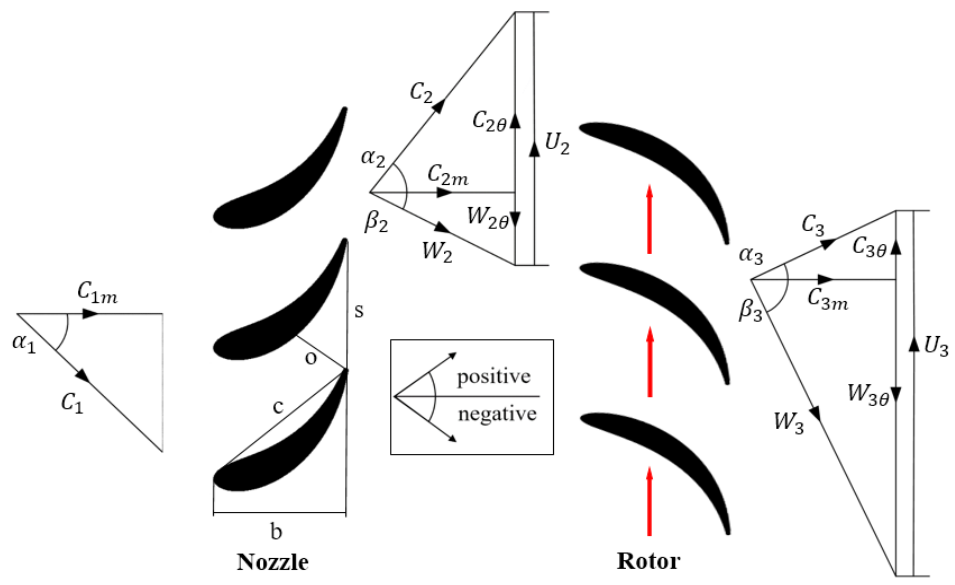
Figure 3. Velocity triangles of a radial outflow turbine [3,12].